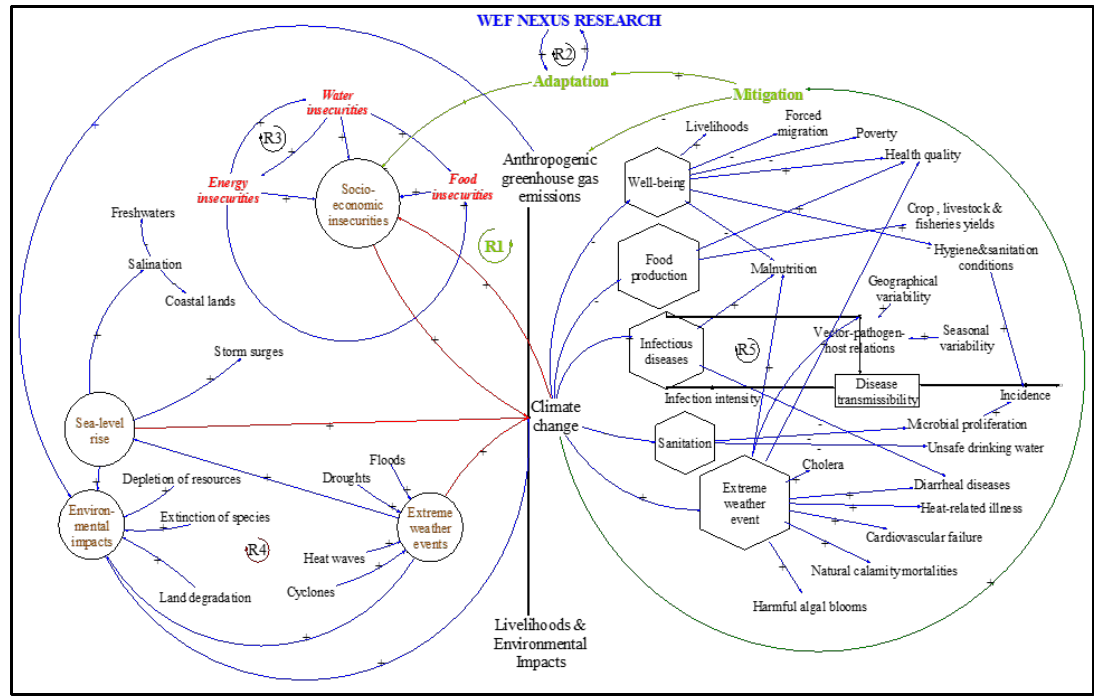
Figure 2. A systemic representation of the water – energy – food (WEF) nexus analytical livelihoods model showing the multi-dimensionality interactions and feedback effects of the system. The left enclosure shows measurable system components (encircled) as related to climate change. The right enclosure shows the impact of climate change (diamond-shaped) with vicious cascading effects on livelihoods and health.